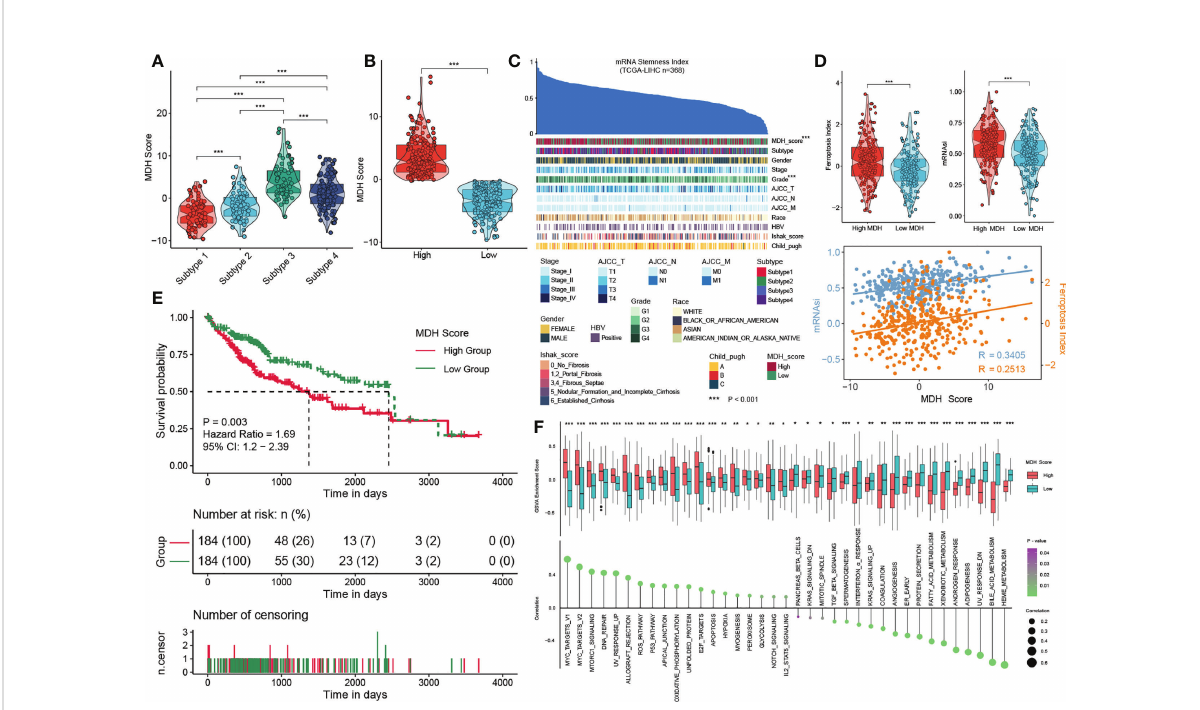
FIGURE 5 Construction of the MDH score. (A) MDH score of distinct MDH subtypes in the TCGA-LIHC cohort. (B) The TCGA-LIHC cohort was divided into two groups based on median expression values of MDH scores. (C) An overview of the association between known clinical features and mRNAsi in patients in the TCGA-LIHC cohort. Columns represent samples sorted by mRNAsi from low to high (top row). Rows represent known clinical and molecular features. (D) mRNAsi score and ferroptosis index in the MDH high- or low-score groups of the TCGA-LIHC cohort. Correlation analysis of mRNAsi scores, ferroptosis index and MDH score in patients in the TCGA-LIHC cohort. (E) Survival analyses for MDH high- or low-score groups of the TCGA-LIHC cohort. (F) GSVA enrichment analysis showing the activation states of biological pathways in the MDH high- or low-score groups. The upper and lower ends of the boxes represent the interquartile range of values. The lines in the boxes represent the median value, and black dots show outliers. The asterisks in A, B, D and F represent the statistical p-value (*P< 0.05; **P< 0.01 and ***P<